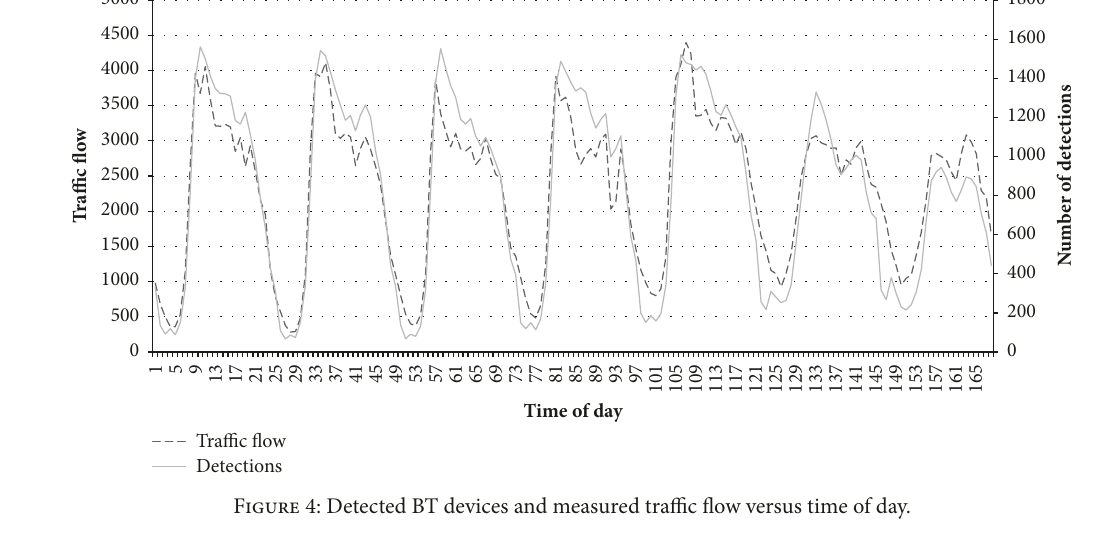
Figure 4: Detected BT devices and measured traffic flow versus time of day.